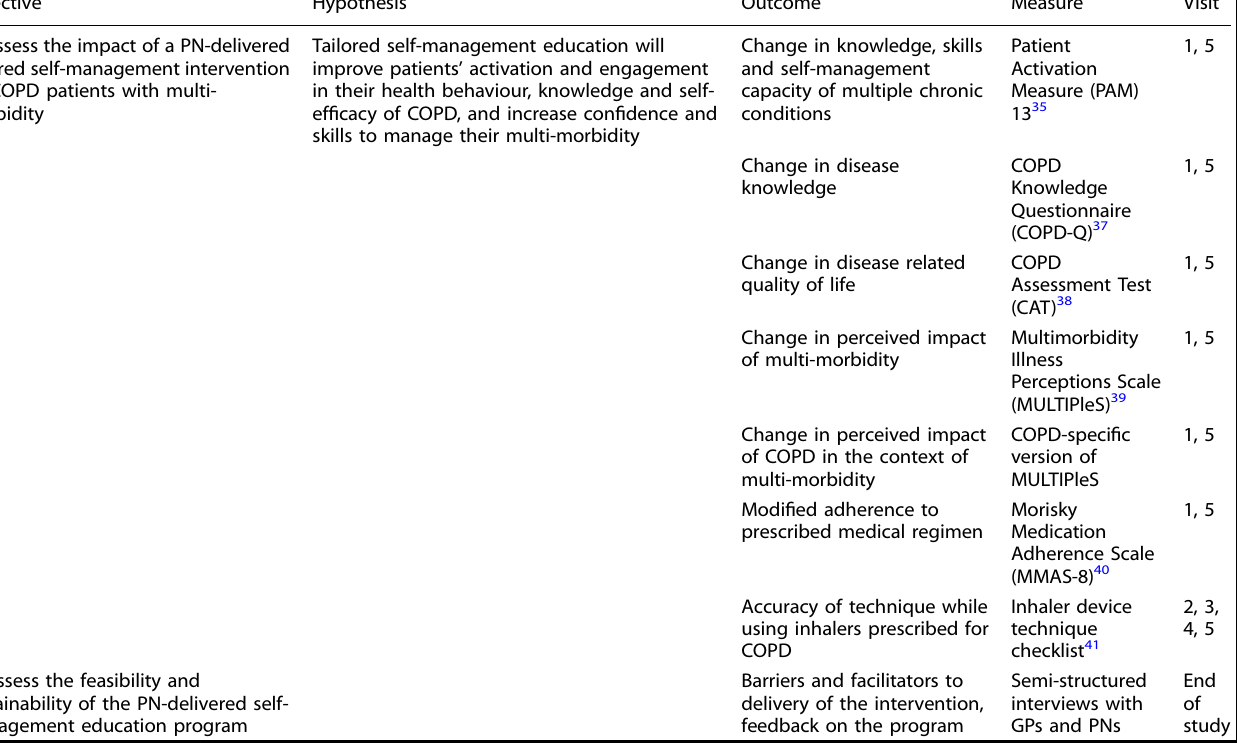
Table 1. Relationship between objectives, outcomes, measures and hypotheses Objective Hypothesis Outcome Measure